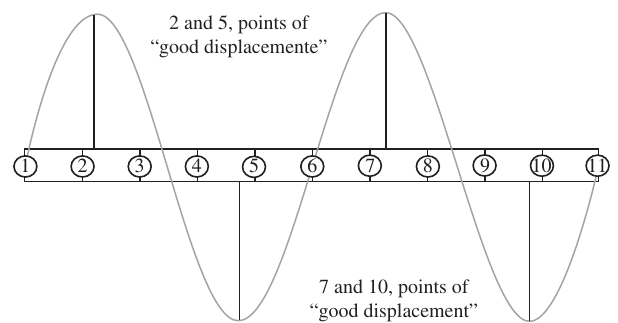
Figure 4. Points of “good displacement” for the fourth mode of vibration of the